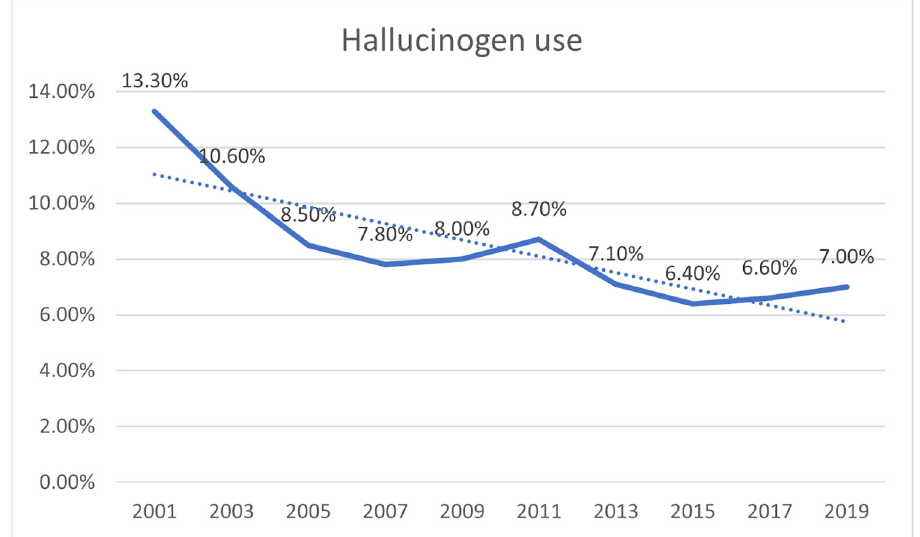
Figure 1. The trend of hallucinogen use among US adolescents 2001–2019. Dotted line represents the trendline.